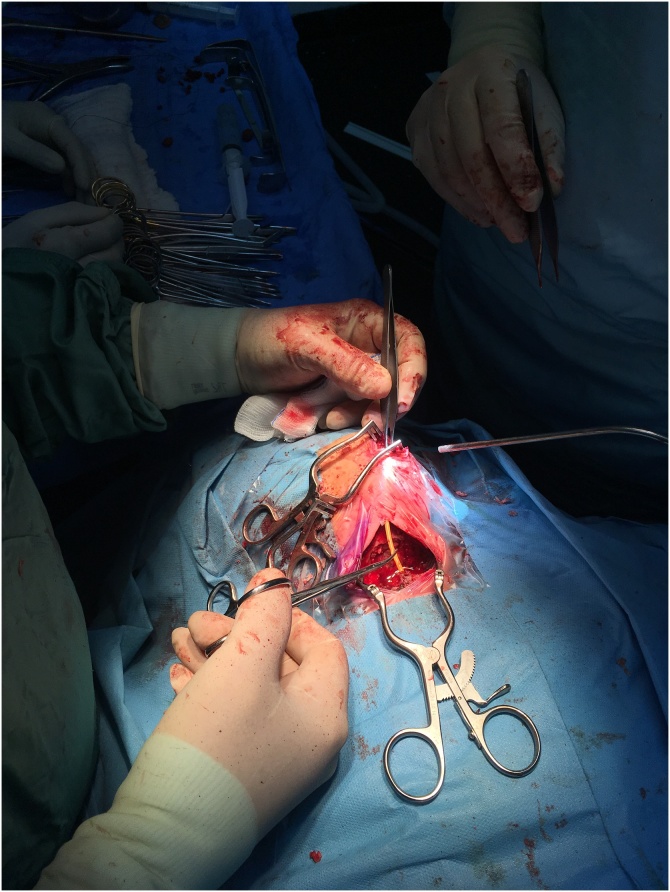
Intraoperative photograph, visualizing the subcutaneous passage of the tube from the occipital horn to the region of the cisterna magna.